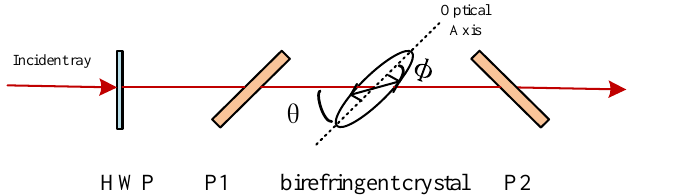
Figure 1. Schematic of the dispersion compensation based on the birefringent plate. P1, P2: Polarizers; HWP: Half-wave